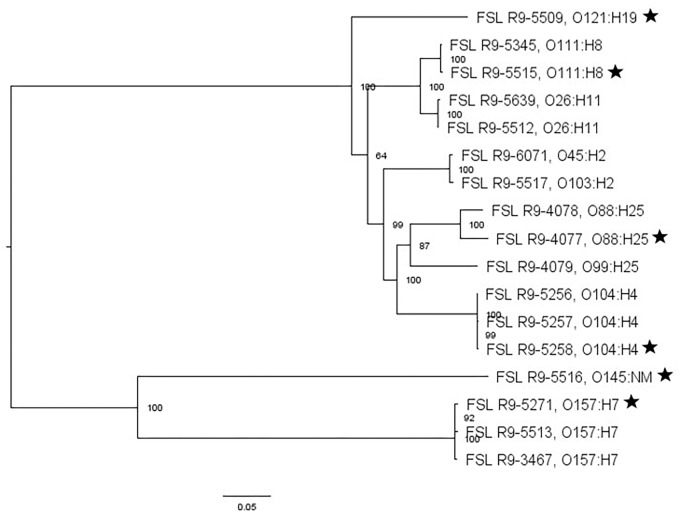
Escherichia coli maximum-likelihood tree based on core SNP analysis using kSNP. The phylogeny for strains was inferred using RAxML and tree was rooted by midpoint. The strain FSL ID is followed by serotype. The node labels represent bootstrap values of 1000 repetitions. The bar indicates 0.05 substitutions per site. Strains marked with a star were selected as representative strains for phenotypic analyses (i.e., PAA experiments).